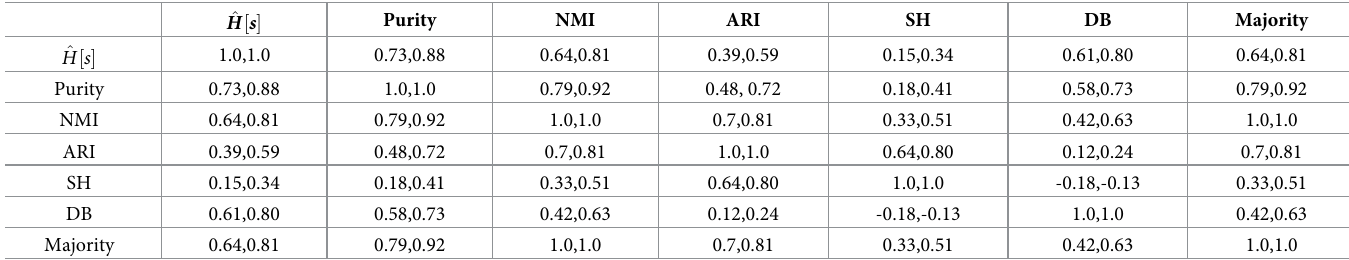
Table 14. Kendall’s τ and Spearman’s correlation result for